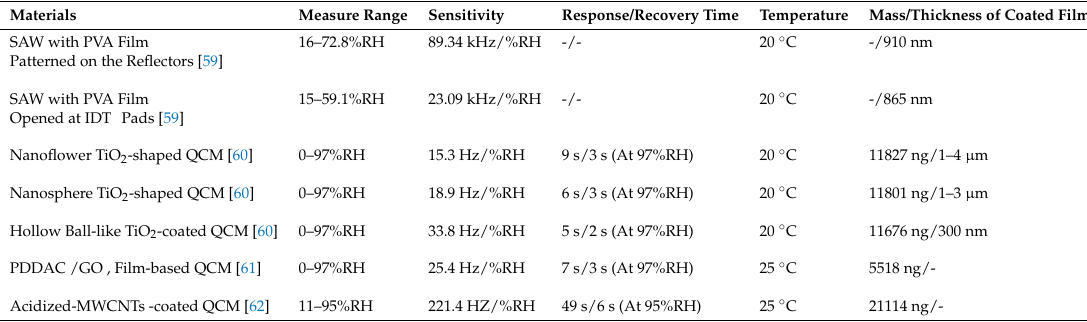
Table 1. Comparison of Sensitivity Characteristics of Humidity